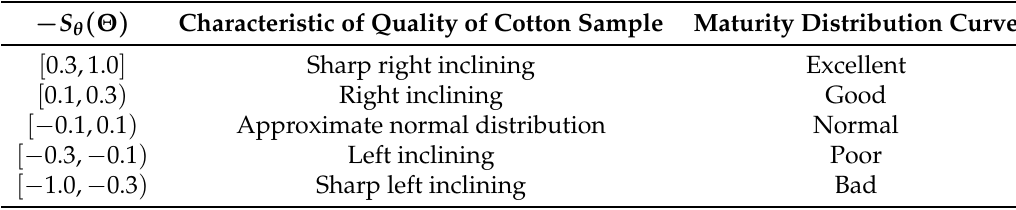
Figure 4. Maturity distribution curves of five cotton samples with different quality. Table 1. Relation among − S θ ( Θ ) , characteristic of maturity distribution curve, quality of cotton sample.